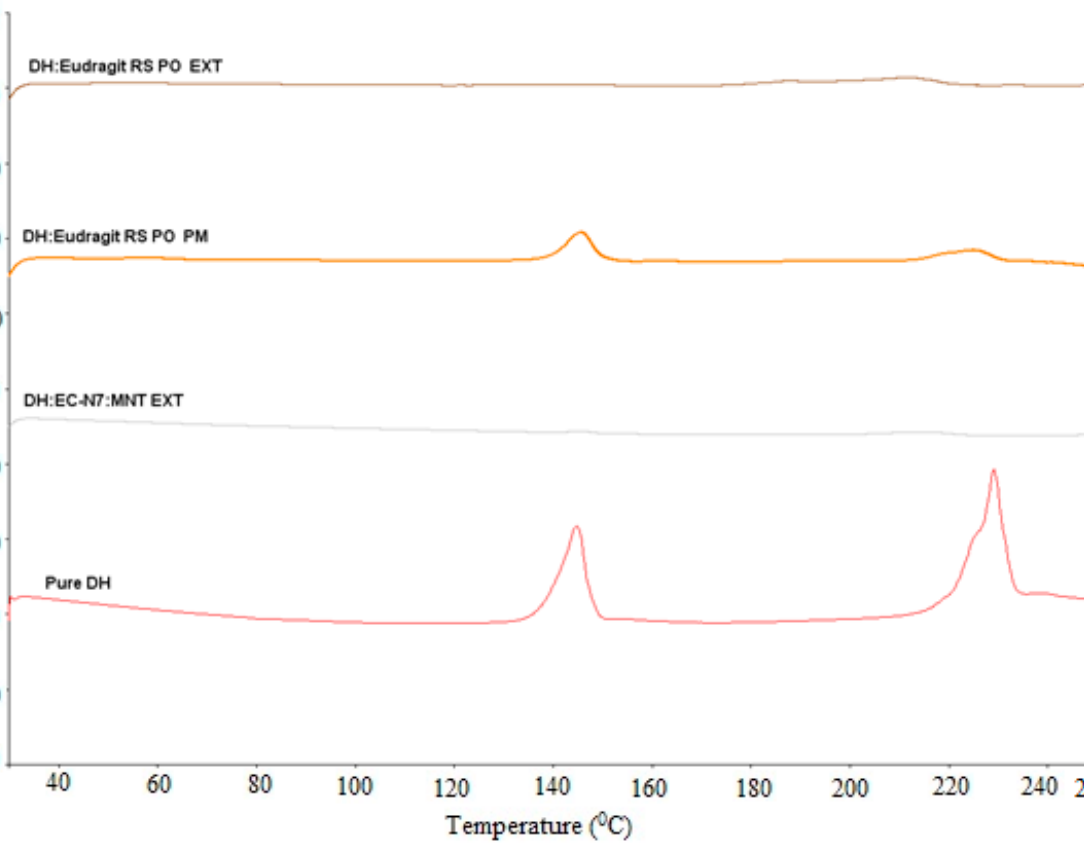
Figure 5. DH/Eudragit ® RS PO (1:2) and DH/EC-N7/MNT (1:2:0.1) DSC studies performed at temperatures of 30–250 °C and a heating rate of 20 °C/min.